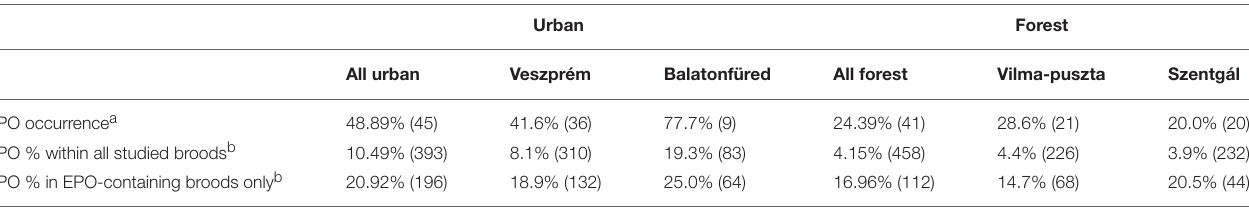
TABLE 1 | Occurrence of extra-pair offspring (EPO), i.e., proportion of studied broods that contained at least one EPO, and the percentage of EPO among all nestlings in the two urban and two forest study sites.